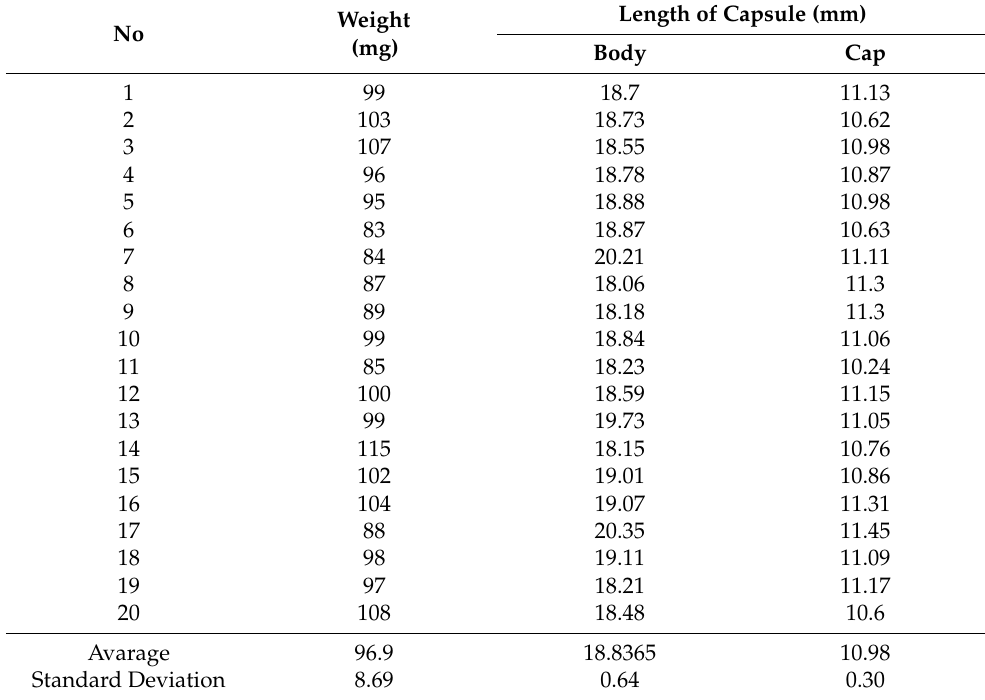
Table 2. Weight and size of hard-shell capsules produced by goatskin